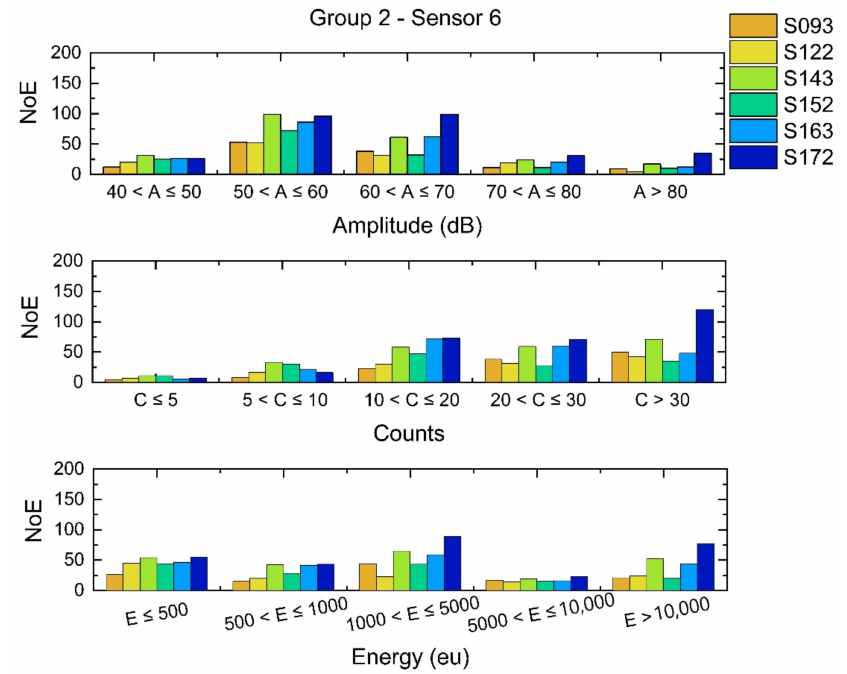
Figure 7. Number of events (NoE) registered during the brittle fracture for Group 2 recorded by sensor 6. Each sample is identified by an ID number “Sxxy” corresponding to the number of slice (xx) and the count of the produced sample in the slice (y). ( Top ) amplitude; ( Middle ) counts; ( Bottom ) energy released by the